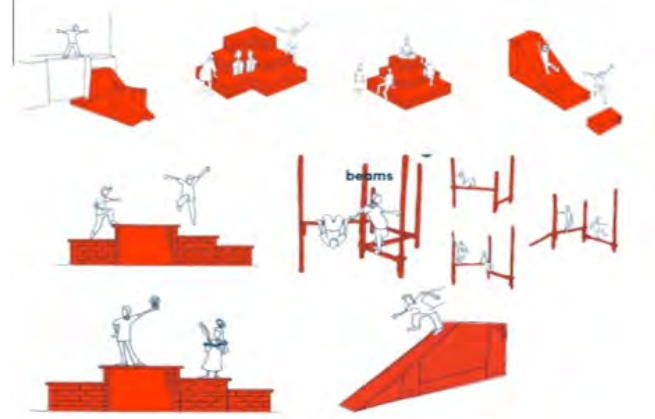
Figure 10. Showing playable spaces (“Ahmed Shemisah’s” Project)